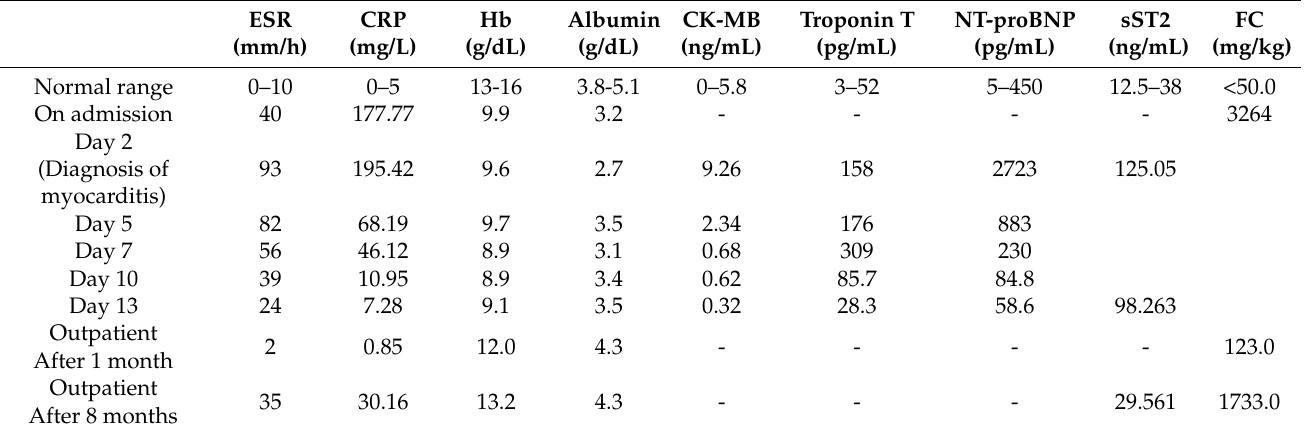
Table 1. Laboratory results.